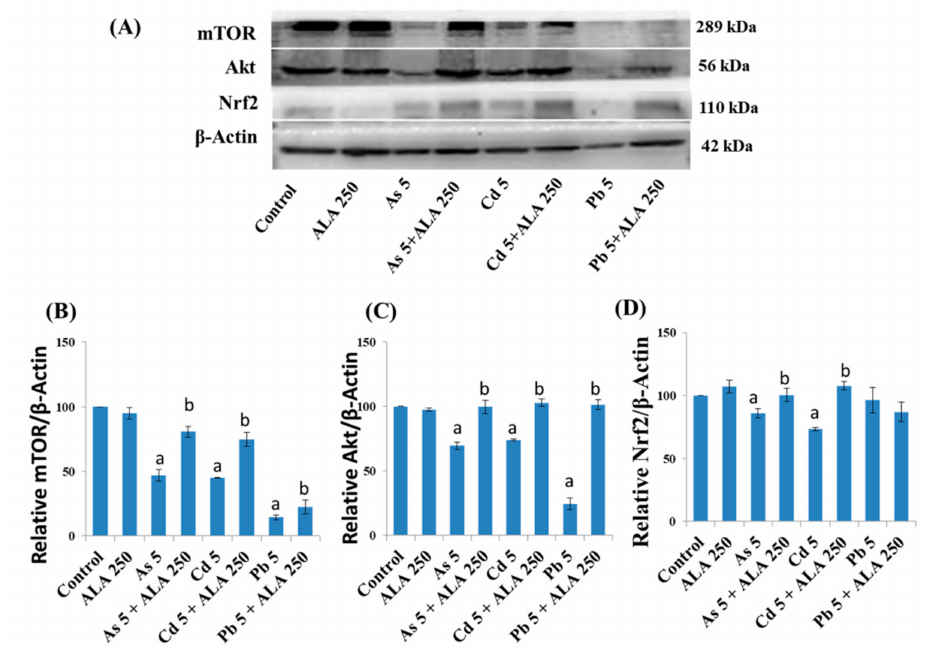
Figure 9. ( A ) Western blot analysis of protein expressions, and quantification of ( B ) mTOR, ( C ) Akt and ( D ) Nrf2 in the PC12 cells after treatment with metals with ALA for 48 h. The values of the bars indicate the mean ± SEM ( n = 3). Here, “a” denotes a significant difference compared to control group ( p < 0.05), and “b” denotes a significant difference compared to the associated metal group ( p < 0.05).